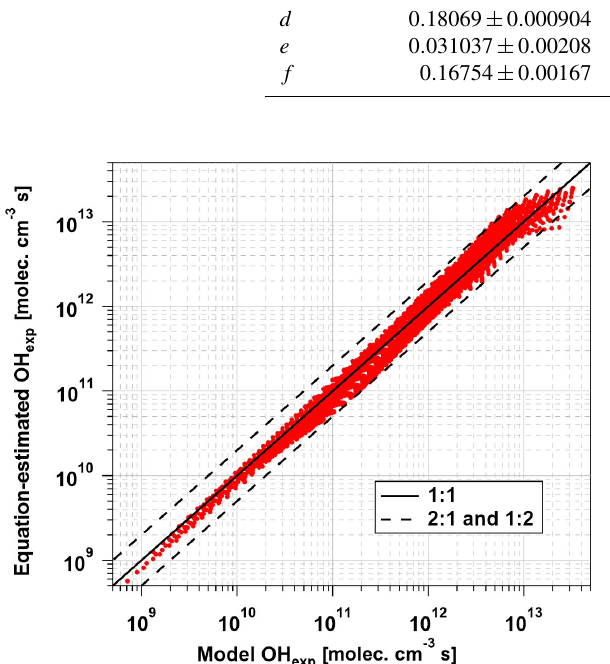
Figure 6. OH exp estimation equation fit coefficients plotted as a function I 254 : I 254 . Trend lines were calculated from exponential regression functions with fit parameters that are presented in Ta- ble